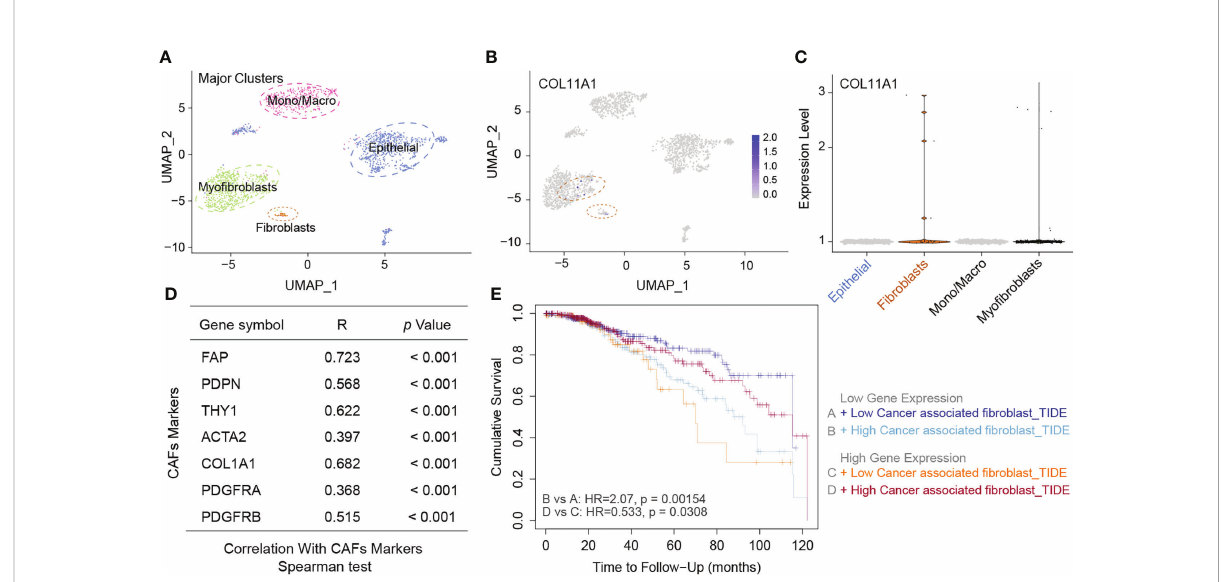
FIGURE 5 High expression COL11A1 positive with CAFs. Analyzed the distribution of COL11A1 in different cell clusters at the single-cell level, and the data were clustered into four clusters, namely Myo fi broblasts, Mano/Macro, Epithelial, and Fibroblasts (A) . COL11A1 was most signi fi cantly distributed in Myo fi broblasts and Fibroblasts. In addition, the expression of this gene was signi fi cantly higher in Fibroblasts than in Epithelial cells (B, C) . COL11A1 was signi fi cantly positively correlated with the CAFs marker gene (FAP, PDPN, THY1, ACTA2, COL1A1, PDGFRA, PDGFRB; p<0.001) (D) . The survival analysis results suggested that the deeper the immune in fi ltration, the worse the prognosis of patients with low expression of COL11A1, and the opposite results of prognosis analysis of patients with COL11A1 high expression (E)